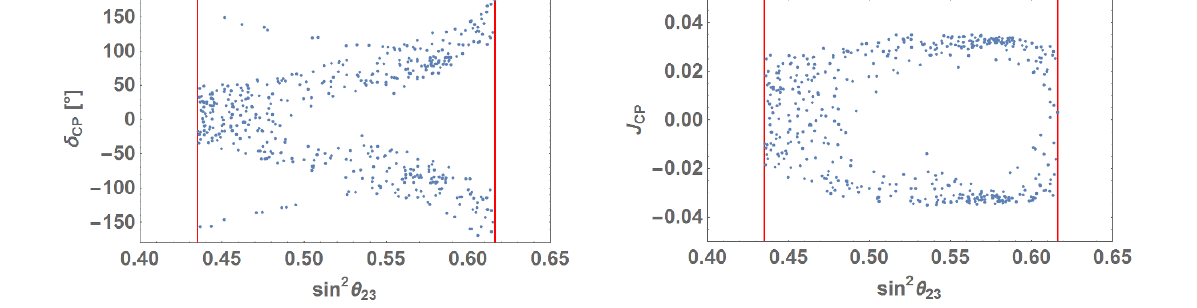
Figure 6 . The prediction of J CP versus sin 2 (cid:18) 23 for IH in model III. The vertical red lines rep- resent the upper and lower bounds of the ex- perimental data with 3 (cid:27) .